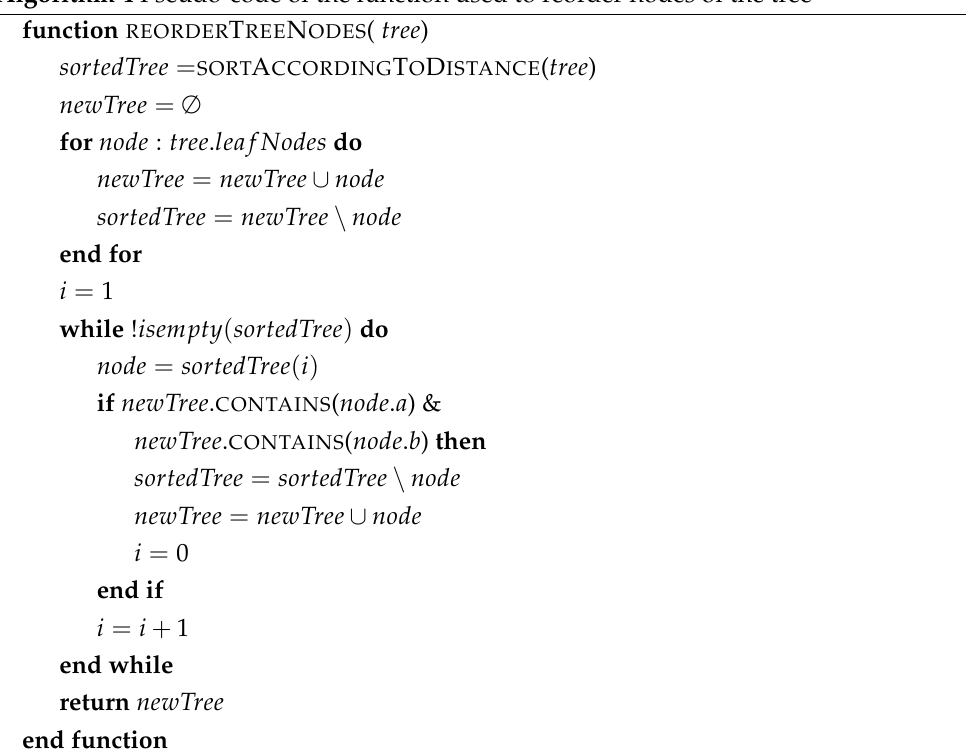
Figure 4. An example dendrogram where colours represent subtrees obtained for three control areas and the top part of the tree (marked black) merges all subtrees. Note that the bottom links of the black subtree start earlier than the top links of the green subtree. Algorithm 4 Pseudo-code of the function used to reorder nodes of the